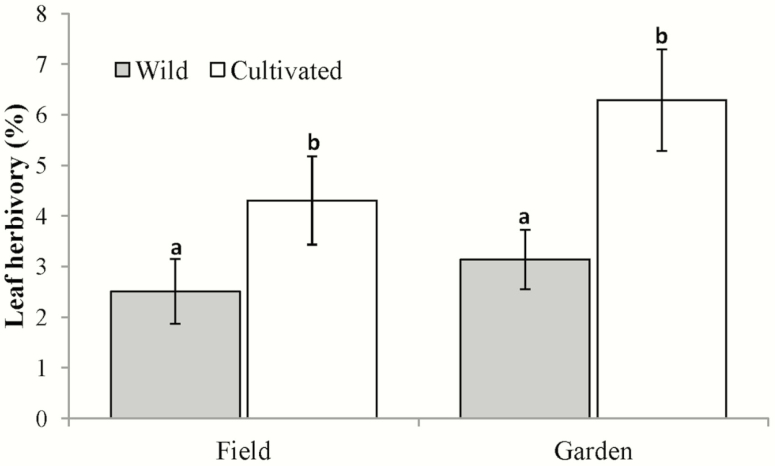
Leaf herbivory (% of the leaf eaten) in wild and cultivated Cnidoscolus aconitifolius in two different environments: in the field (field) and in a common garden (garden). Values are means ± 1 SE. Different letters indicate statistically significant differences.